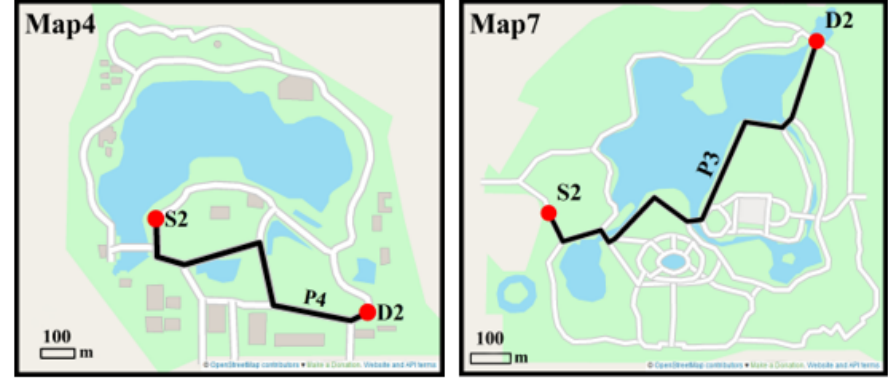
Figure 11. Two simplified routes with larger angular step depths and lower choice percentages .